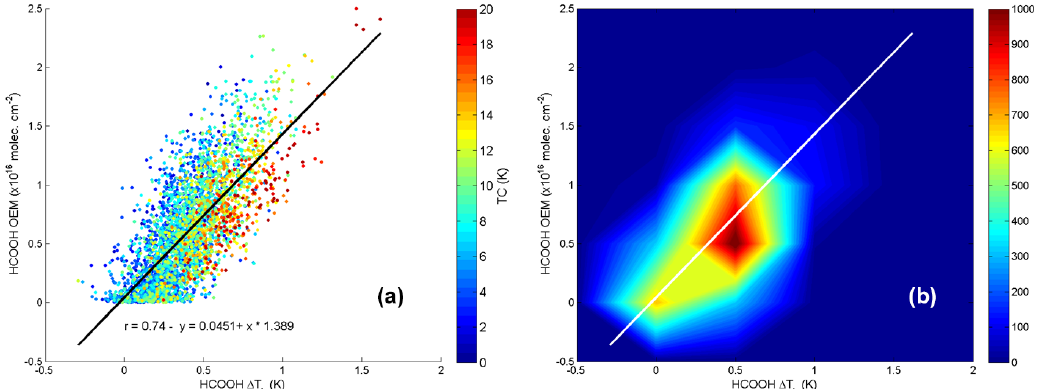
Figure 3. (a) Scatter plot of all the retrieved total columns using the optimal estimation method and the corresponding HCOOH (cid:49)T b . The black line corresponds to the linear regression. Each data point is colored based on its thermal contrast value. (b) Distribution of points density from the scatter plot. The number of points is highlighted with the color scale. The linear regression is also reported by a white line.